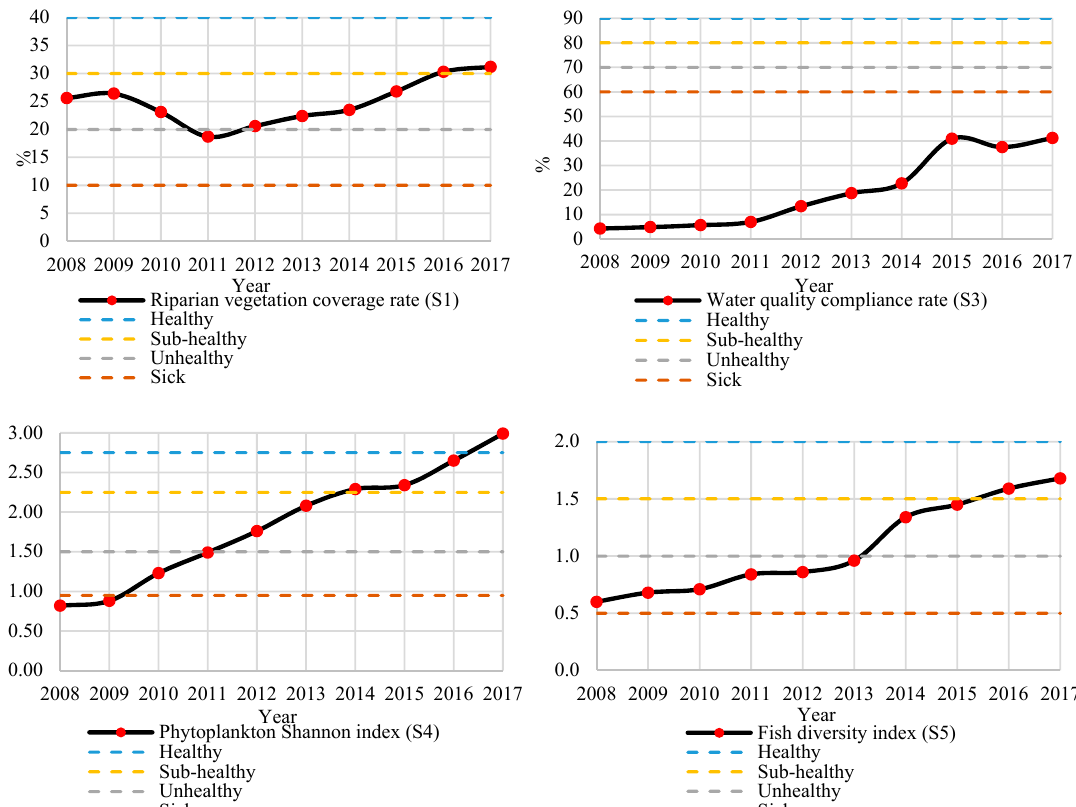
Figure 7. Trends of the main indicators of the state subsystem from 2008 to 2017.